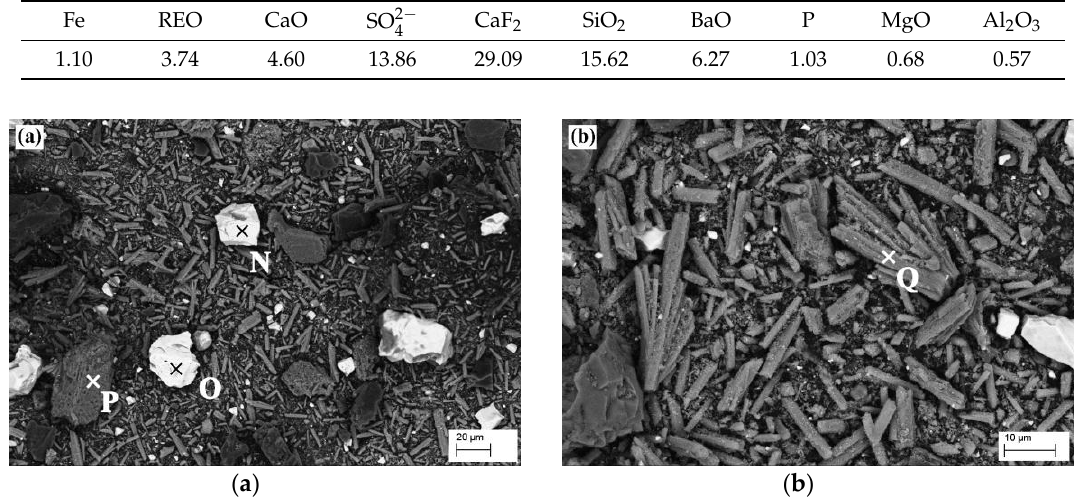
Figure 19. XRD patterns of the leaching residues. Table 7. Chemical composition of the leaching residues (wt. %).